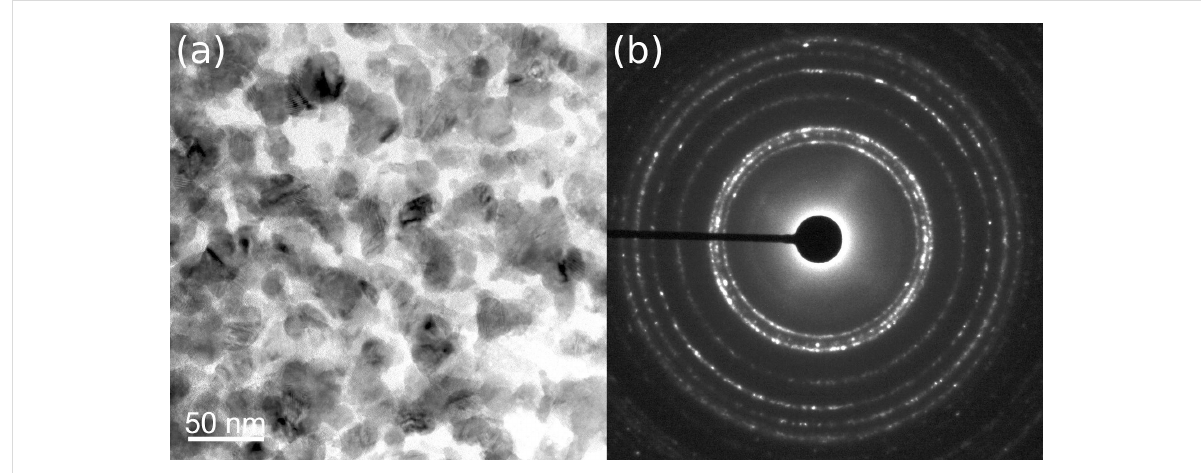
Figure 1: (a) Bright-field TEM micrograph of the nanograined pure ZnO thin film deposited on a sapphire substrate by the novel liquid ceramics method. Electron diffraction pattern (b) shows only rings from the ZnO wurtzite structure; no texture is visible. Bright spots originate from the sapphire substrate.